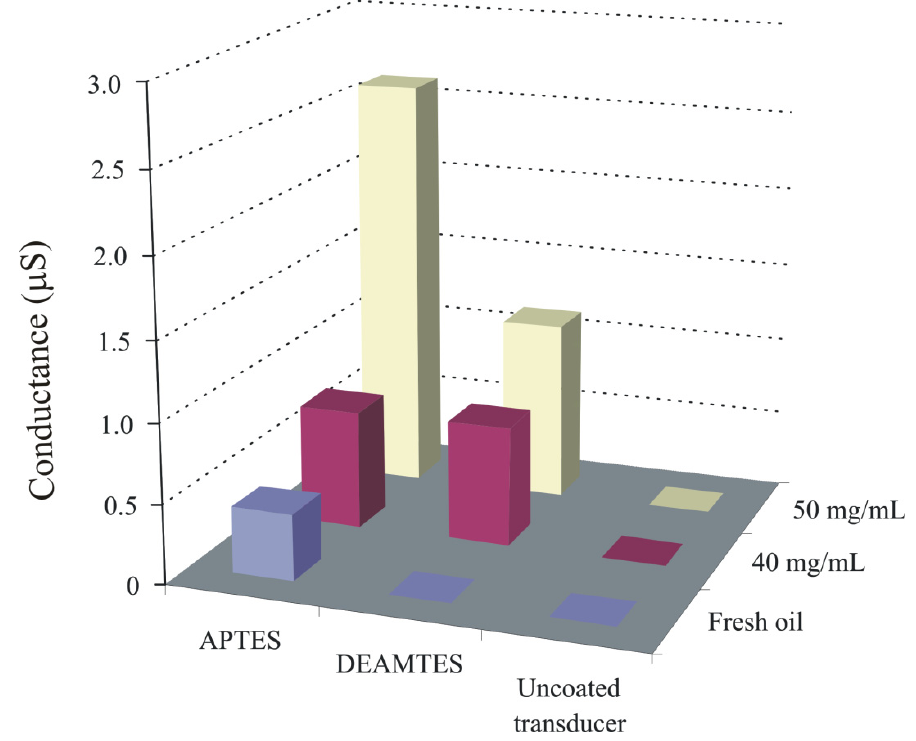
Figure 6. Normalized sensor responses of DEAMTES and APTES layers, while, exposing to 40 mg or 50 mg ammonium salt of capric acid in fresh oil, at room temperature and 20 Hz frequency. These responses are compared with uncoated interdigital transducer